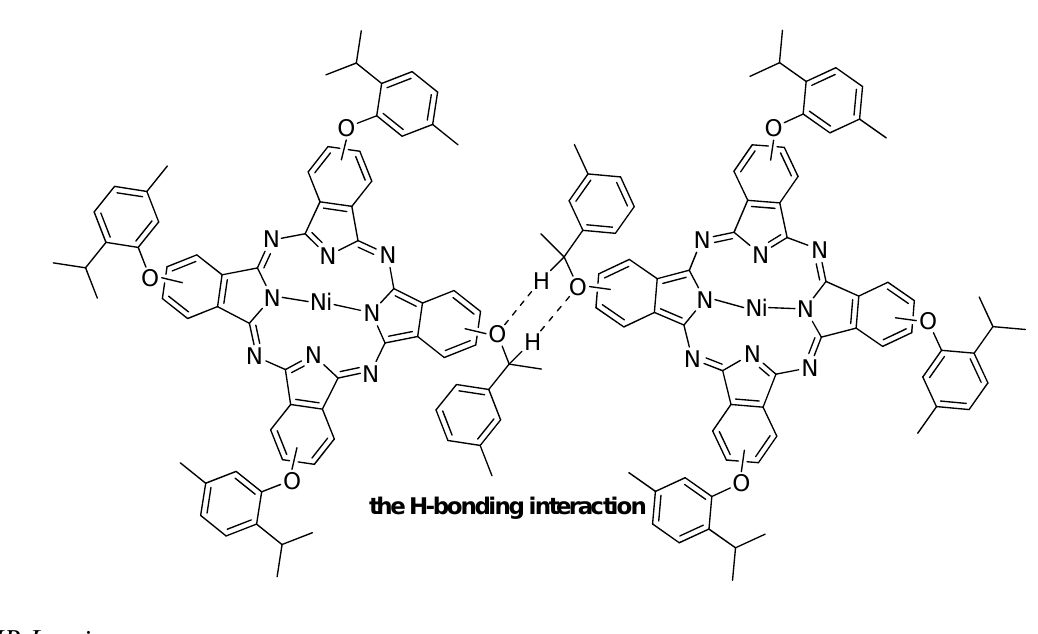
Figure 4. 1a dimer in H-bonding